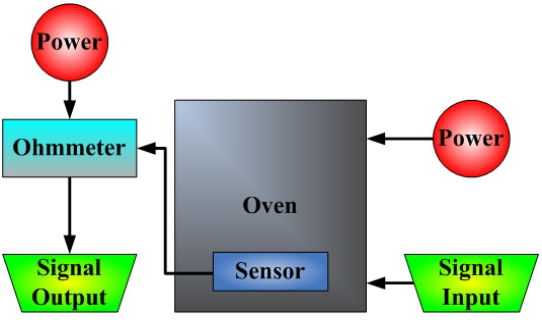
Figure 7. Calibration system of micro temperature sensor.